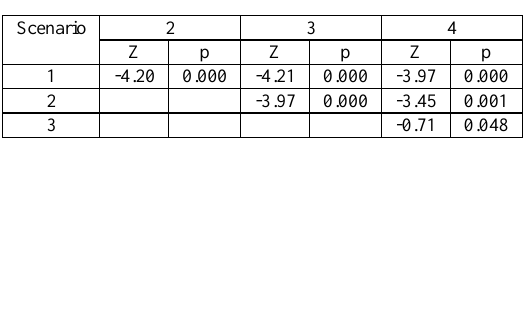
Table 4. Wilcoxon signed-rank test results (both